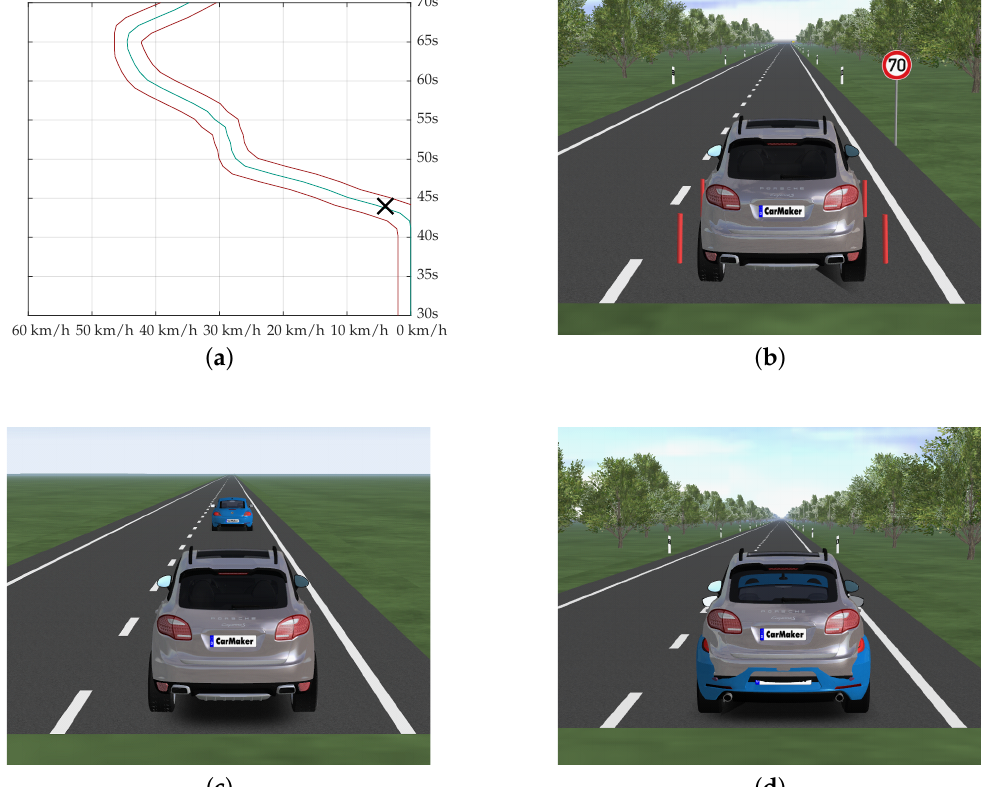
Figure 1. Visual display options for human driver guidance. ( a ) v ( t ) -diagram, ( b ) Traffic signs, ( c ) Vehicle ahead, ( d ) Ghost vehicle.